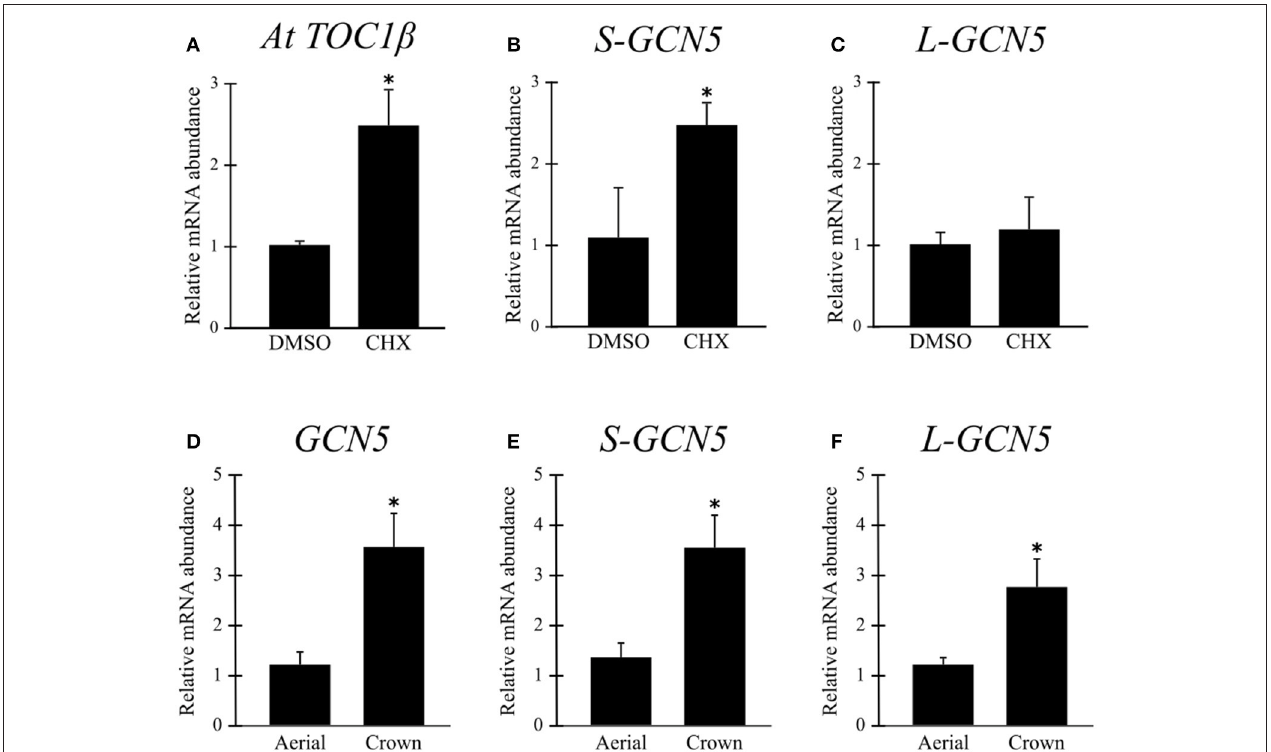
FIGURE 2 | The S-GCN5 transcript is degraded by the nonsense-mediated decay pathway. (A–C) Relative transcript abundance of AtTOC1 β (positive control), S-GCN5, and L-GCN5 following cycloheximide (CHX) or control (DMSO) treatments. (D–F) Relative transcript abundance of GCN5, S-GCN5, and L-GCN5 in aerial and crown tissues. Error bars represent the standard deviation of three biological replicates. An asterisk indicates a statistically significant difference ( P <